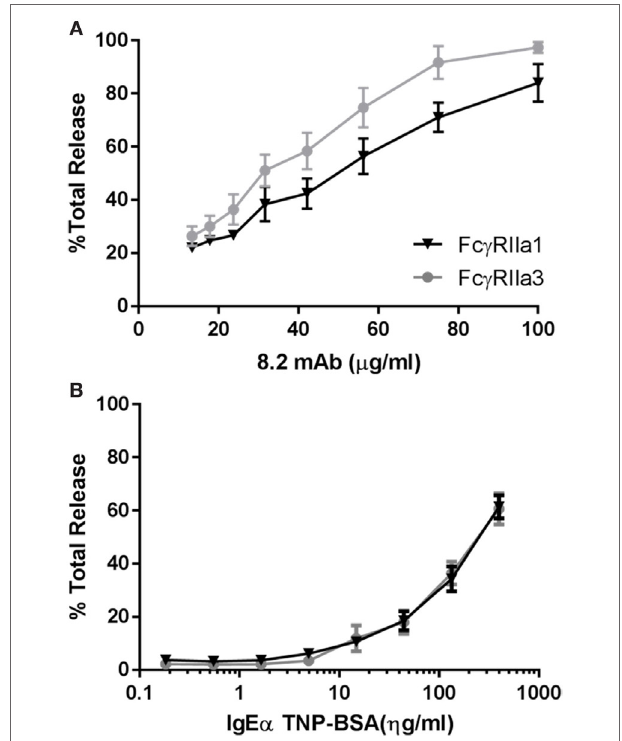
FigUre 6 | Increased levels of β -hexosaminidase release. RBL cells expressing human allelomorphs Fc γ RIIa1-R 131 ( ▾ ) or Fc γ RIIa3 ( ● ) as indicated. Transfectants were stimulated with (a) anti-Fc γ RIIa mAb 8.2 agonist (100–13.35 µg/mL) and (B) IgE anti-TNP/TNP:BSA (0.1–400 ng/mL) for 30 min at 37°C. Supernatant was then incubated with β -hexosaminidase substrate (4 mM p-NAG) and the percentage normalized cell total OD plotted as a dose response curve (mean ± SEM, n = 3). Student t -test, p-value =